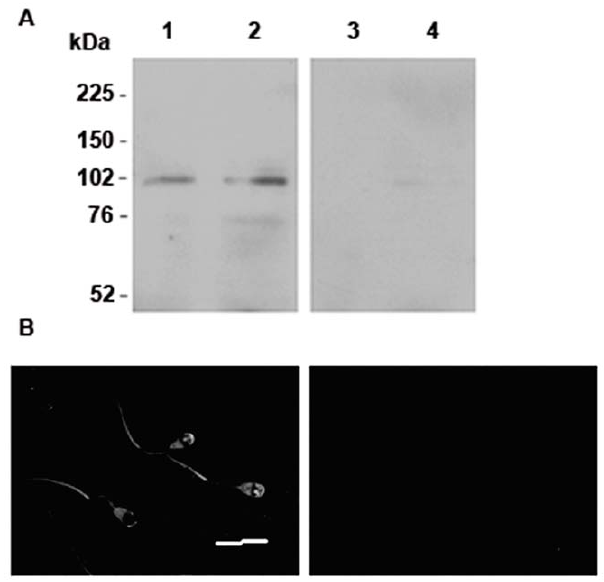
Figure 3. Expression and localization of TRPV1 in bovine spermatozoa. A : Sperm proteins were extracted and subjected to SDS-PAGE immunoblotting with a specific antibody against TRPV1. Lanes 1–2: antiTRPV1, lanes 3–4: antiTRPV1 plus blocking peptide, (n=3). B : Immunolocalization of TRPV1; left panel: spermatozoa incubated with antiTRPV1; right panel: spermatozoa incubated with IgG fractions from non-immunized rabbits at the same concentration that the primary antibody (n=3); Scale bar: 20 m m (Magnification, X600).